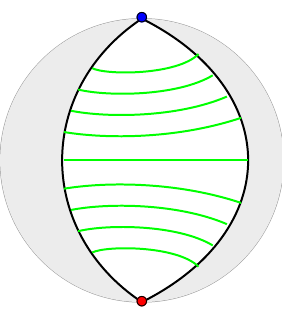
Figure 9. The empty AdS 3 wedge consisting of two KR branes. The bulk geometry is the AdS 3 global patch. The green curves are representatives of the degenerate RT surfaces calculating the entanglement entropy between the two defects (the blue dot and the red